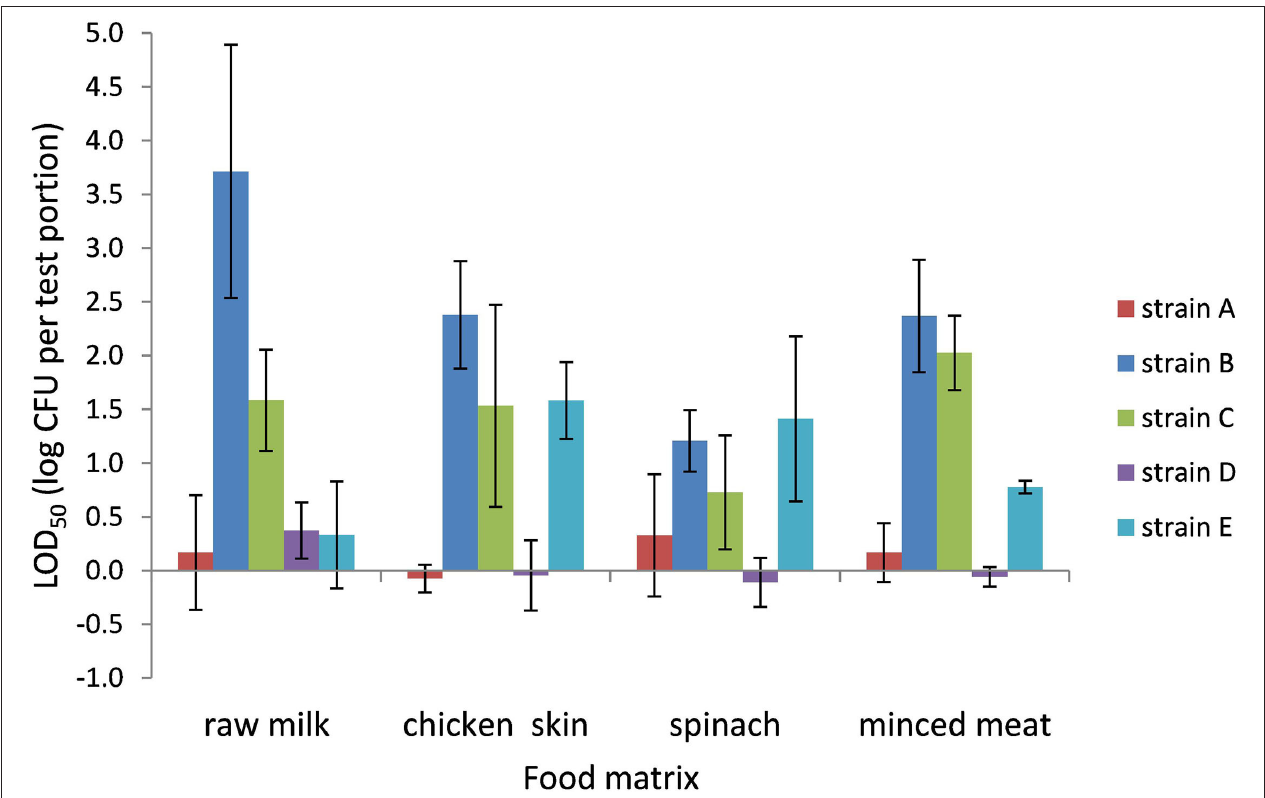
FIGURE 2 | LOD 50 of C. jejuni strains A, B, and D and C. coli strains C and E. Enrichment in Preston broth, including food matrices, namely, raw milk ( n = 3), chicken skin ( n = 3–4), frozen spinach ( n = 3–4), and frozen minced meat ( n = 2–3). Error bars indicate the standard